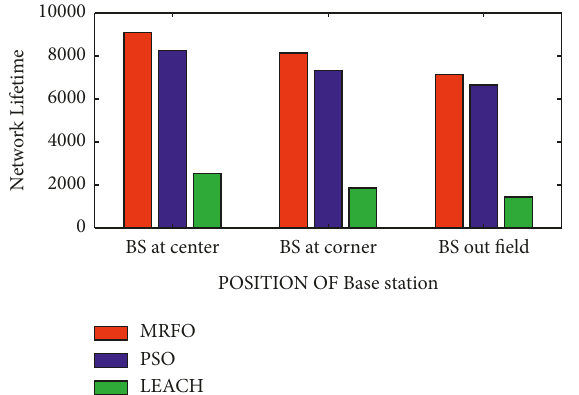
Figure 19: Number of rounds (lifetime) for 400-node network with 40 CHs.